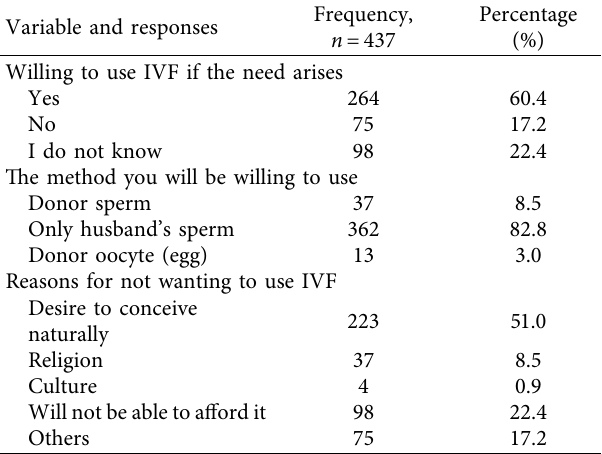
Table 6: Respondents’ preparedness to use IVF